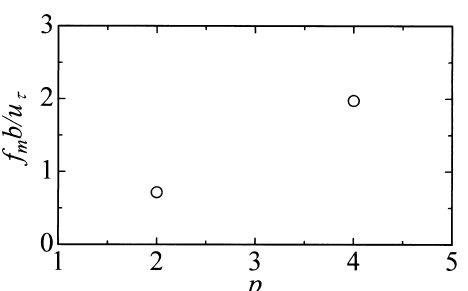
Figure 4 Non-dimensional frequency of momentum